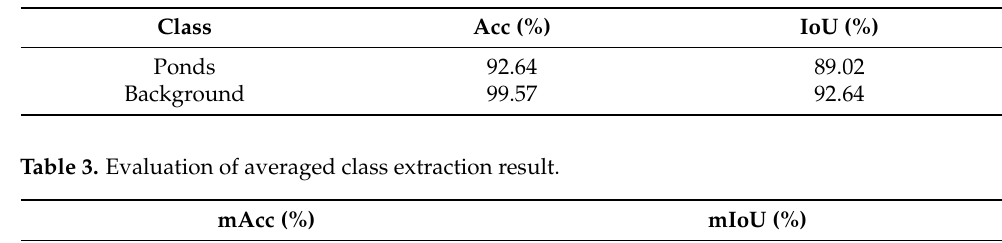
Table 2. Evaluation of single class extraction result.